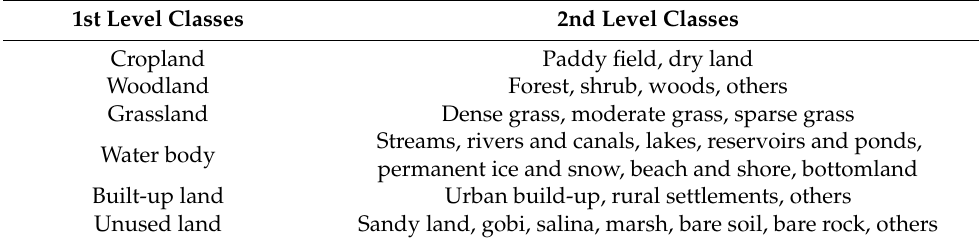
Table 2. The land use classification